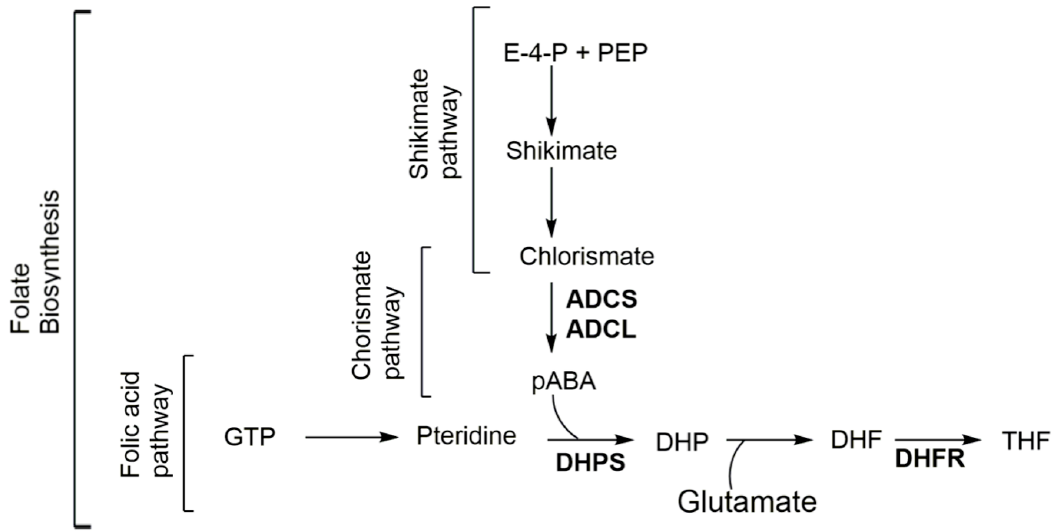
Figure 1. Folate biosynthesis through the shikimate-chorismate-folate (SCF) biosynthetic pathway. ADCL amino-deoxychorismate lyase; ADCS amino-deoxychorismate synthase; DHF dihydrofolate; DHP dihydropteroate; DHFR dihydrofolate reductase; DHPS dihydropteroate synthase; E-4-P erythrose-4-phosphate; GTP guanosine-5 ′ -triphosphate; pABA para-aminobenzoic acid; PEP phosphoenolpyruvate; and THF tetrahydrofolate.